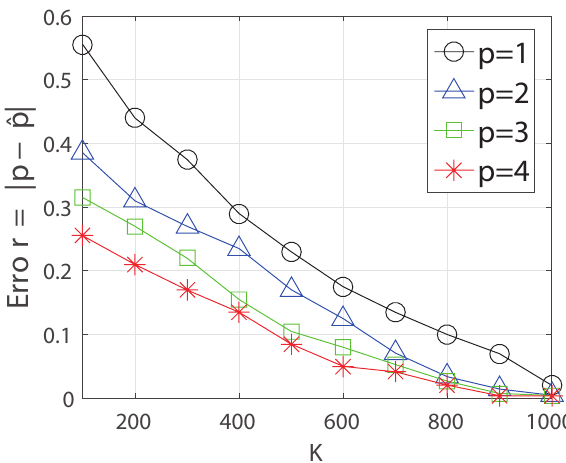
Figure 4. Simulation result for the estimation error | p − ˆ p | with respect to the sampling cost K for the algorithm DPE ( K ). ( N = 1000.)